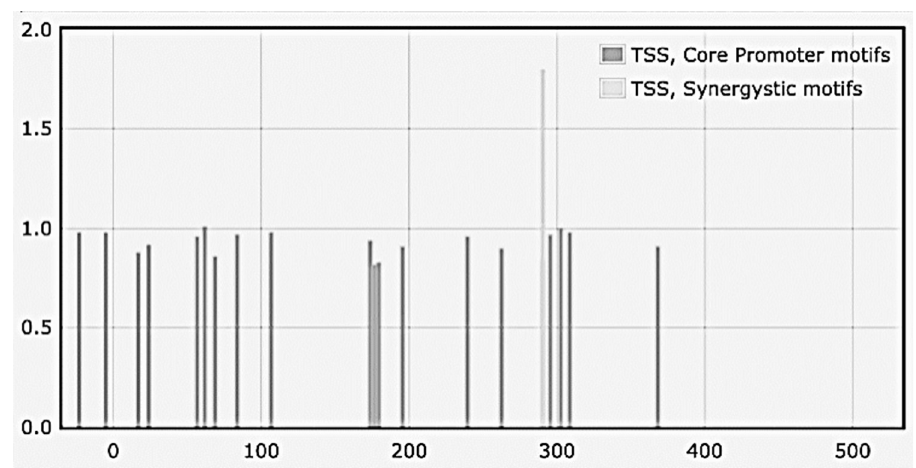
Fig 12. Core promoter motifs of the NANOGP8 promoter region in CD133 + GBM gDNA clones analyzed using the YAPP Eukaryotic Core Promoter Predictor.